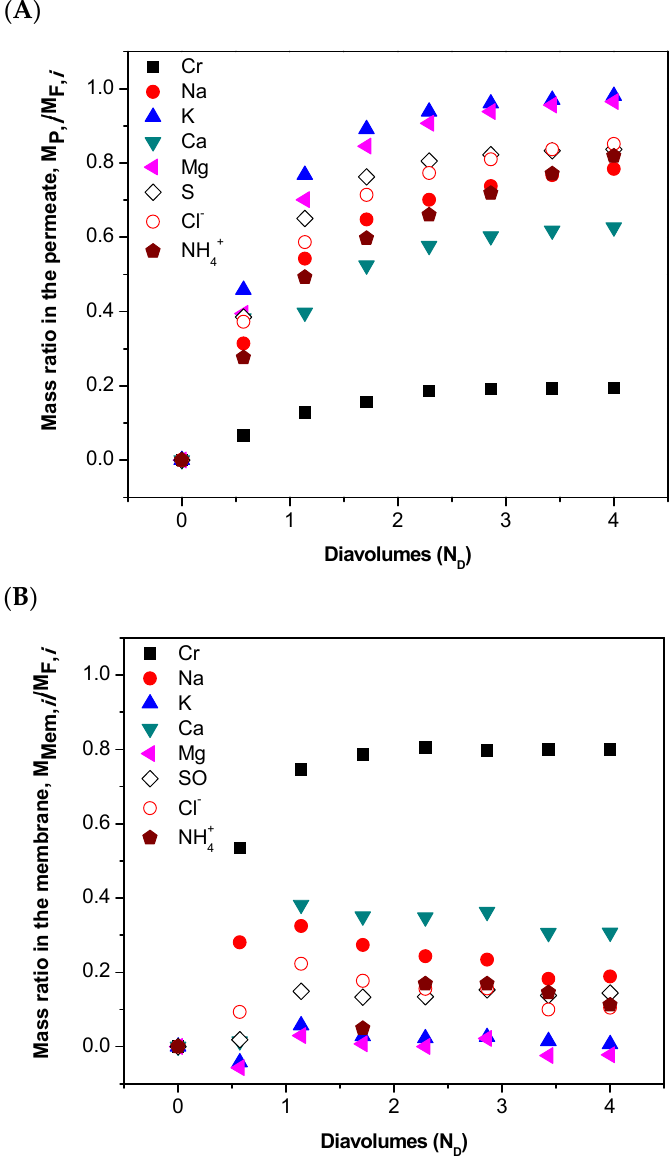
Figure 5. ( A ) Mass ratio of each compound permeated and ( B ) mass ratio of each compound retained in the cs-PES MF022 membrane during diafiltration with the cs-PES MF022 membrane at 20 bar. Mass ratio of each compound was calculated in reference to the total mass of the same compound, M F,I , in the SW30 concentrate of a synthetic tannery effluent before diafiltration (diafiltration feed solution). Note that the electric charge of the elements quantified by ICP-AES was omitted, as this technique quantifies the total amount of the element in the solution independently of its electric